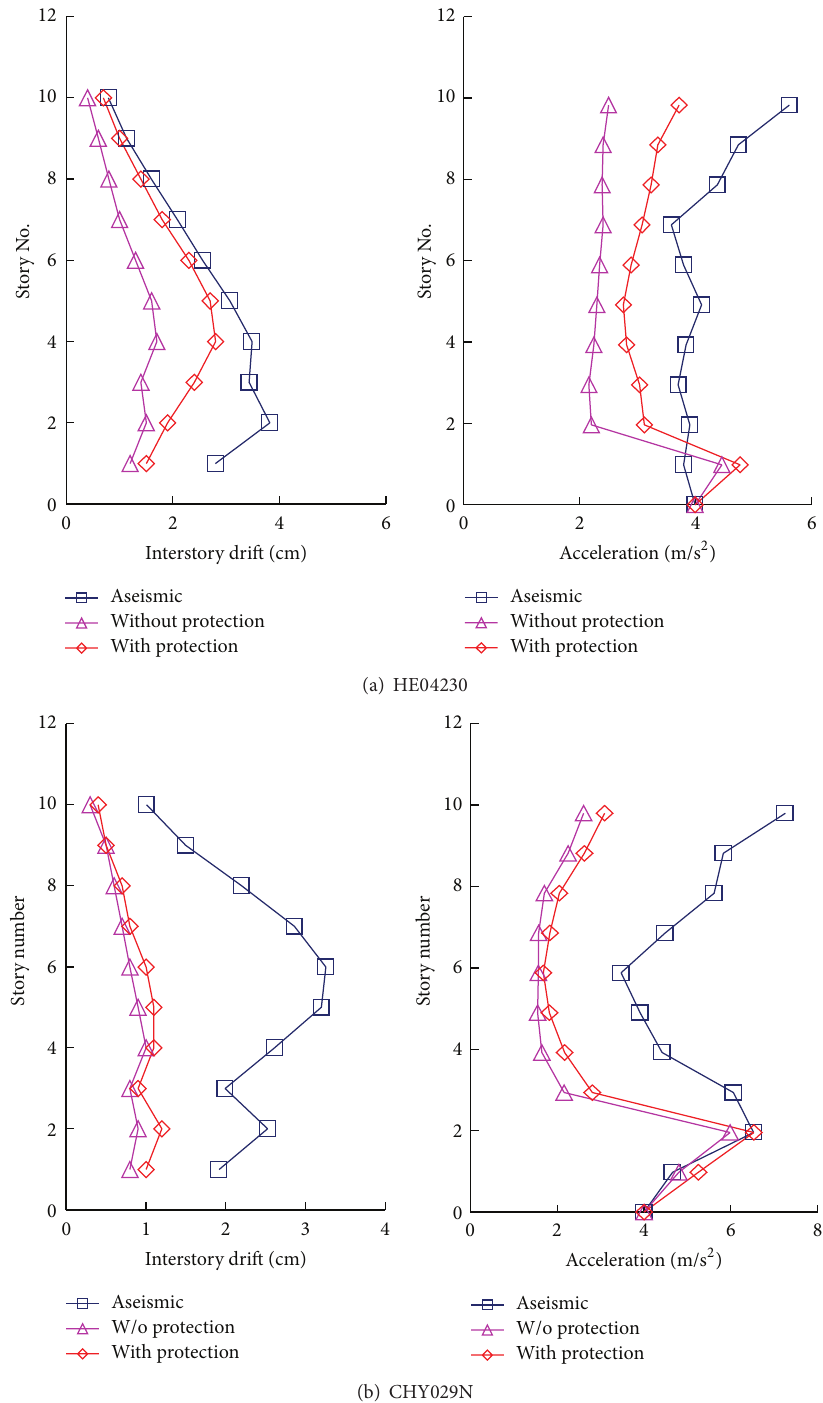
Figure 11: Responses of different structures under different earthquake waves. (a) HE04230; (b) CHY029N.